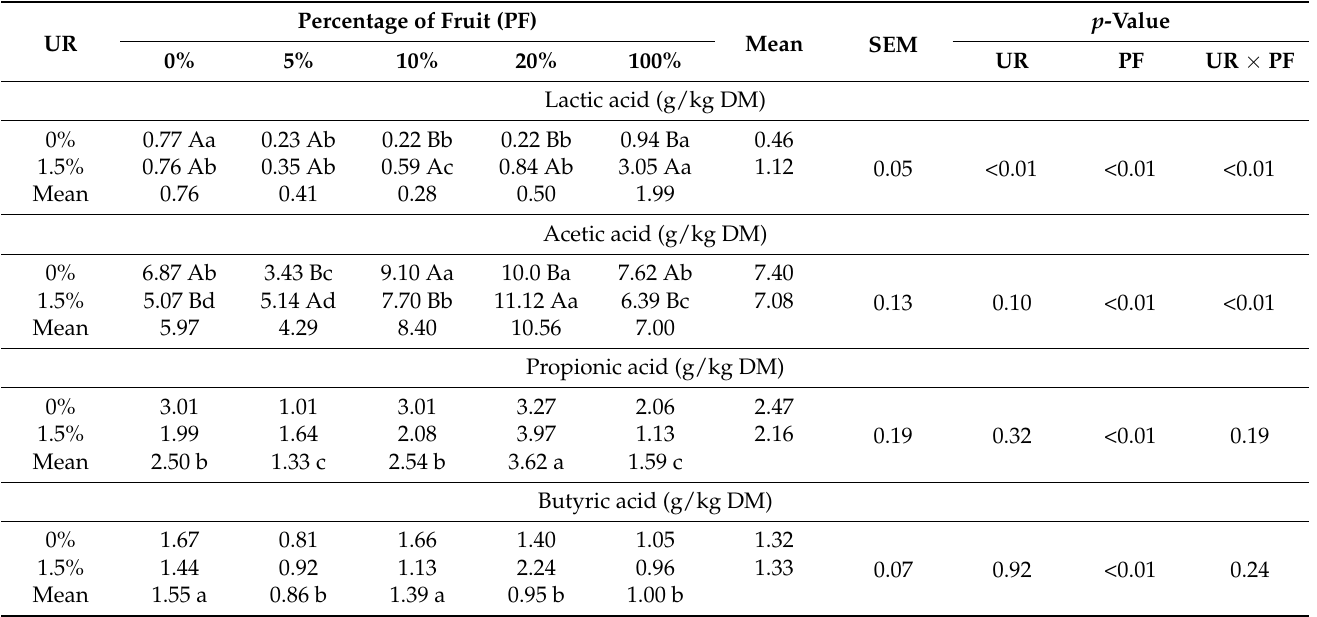
Table 6. Volatile fatty acids (VFA) contents of silages with different mixtures of melon biomass and addition of urea.